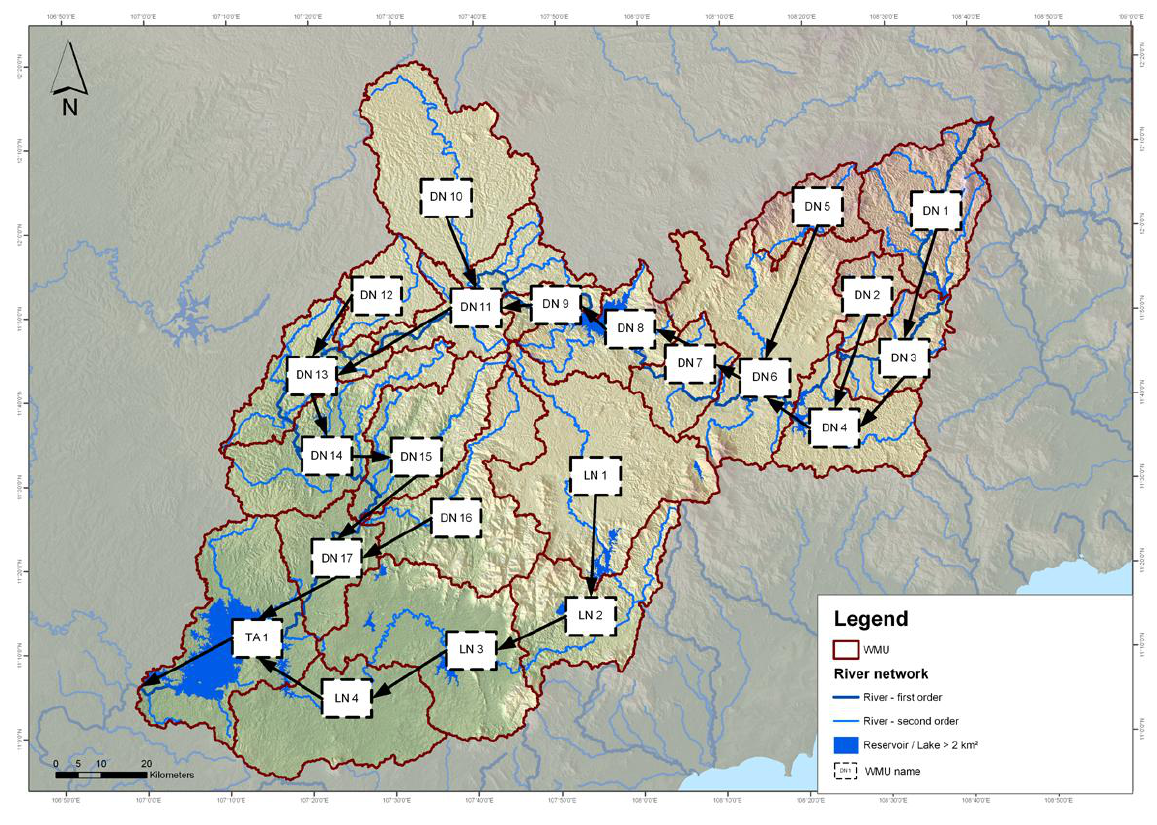
Figure 4. WMU cascade upper Dong Nai basin (Water Management Units: DN 1- DN 17, LN 1-LN 4, TA